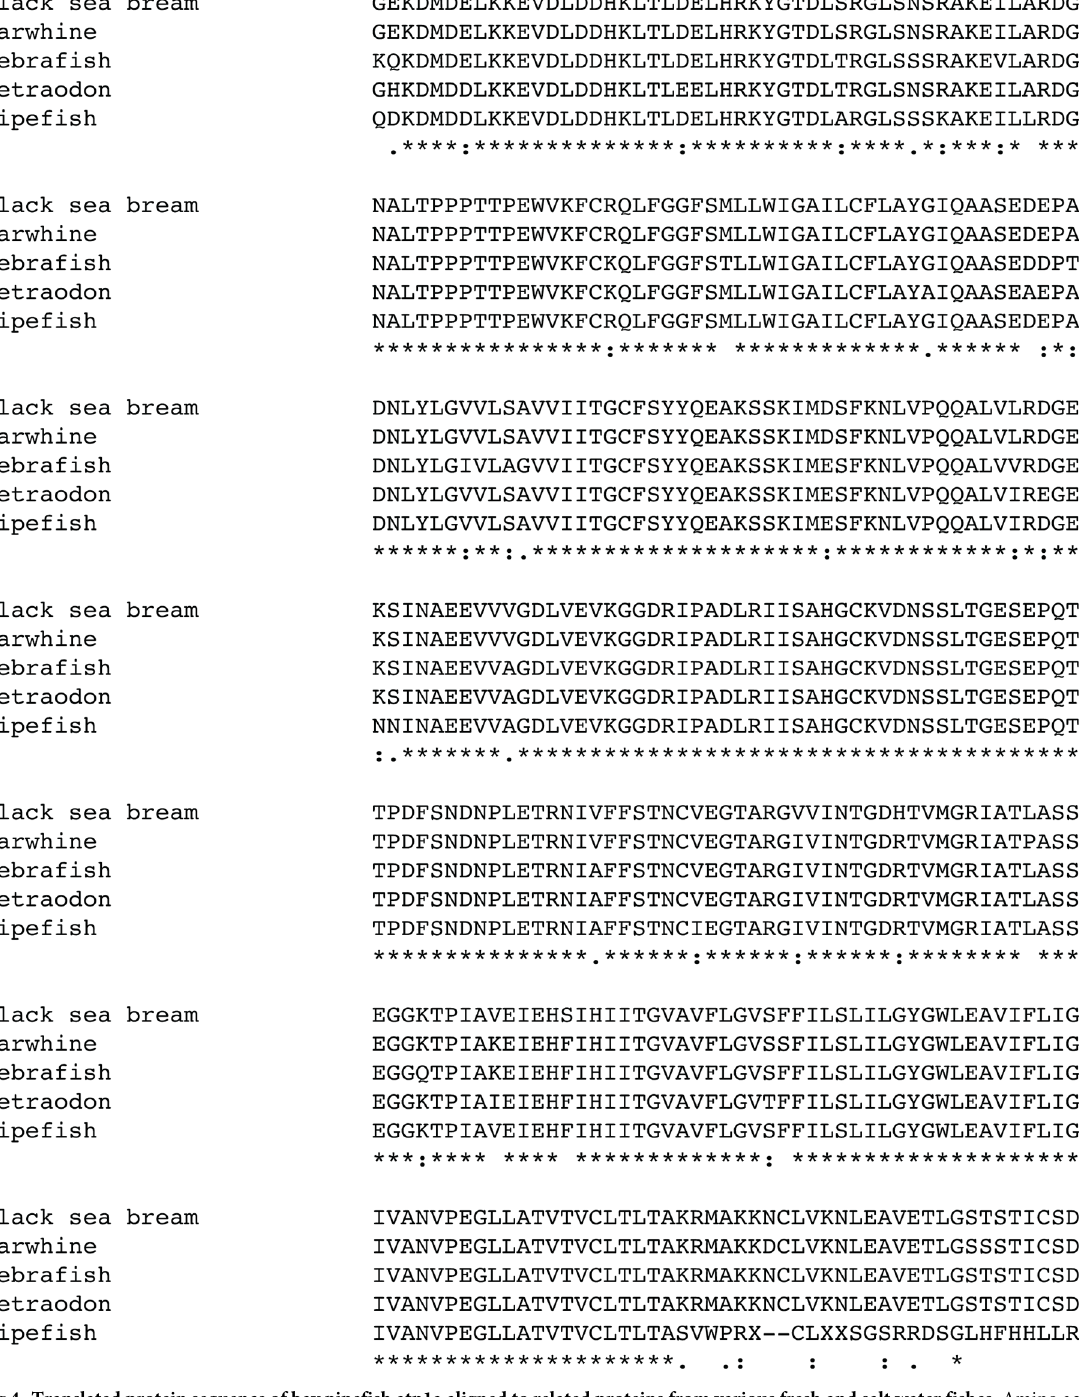
Fig 4. Translated protein sequence of bay pipefish atp1a aligned to related proteins from various fresh and salt water fishes. Amino acid residues conserved in all species are indicated with a ‘ � ’, highly similar amino acids with a ‘:’ and similar amino acids with a ‘.’. The NCBI accession numbers of aligned proteins are; black sea bream, ABR10300.1, tarwhine, AAT48993.1; zebrafish AAI63629.1; tetraodon, CAF97804.1. The first conserved amino acid of the pipefish protein, the lysine residue (K), corresponds to amino acid 25 of the zebrafish reference